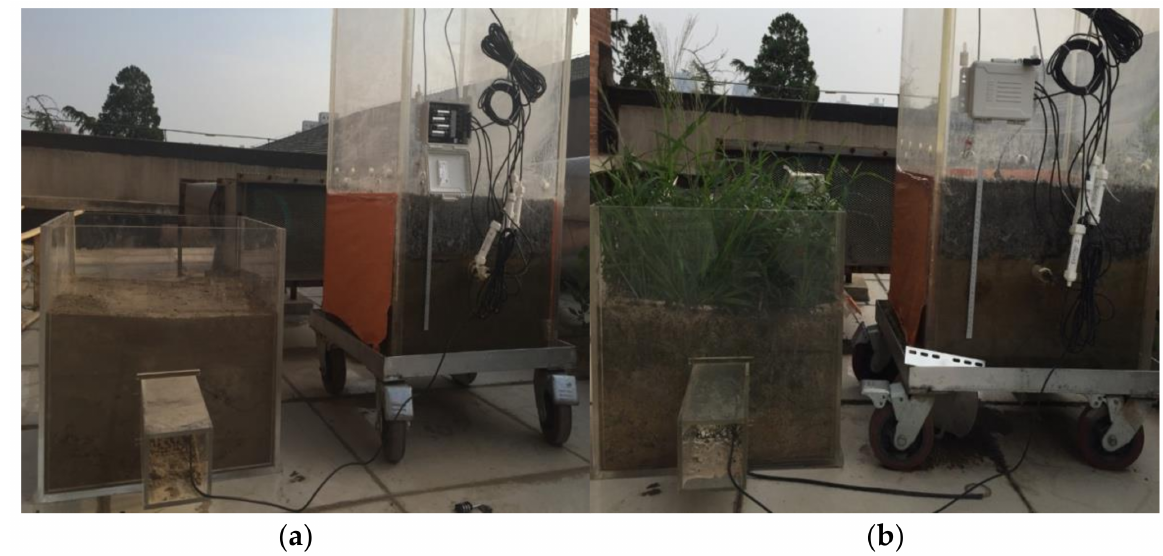
Figure 2. Experimental layout of permeable concrete pavement: ( a ) control group of bare soil; ( b ) control group of nature